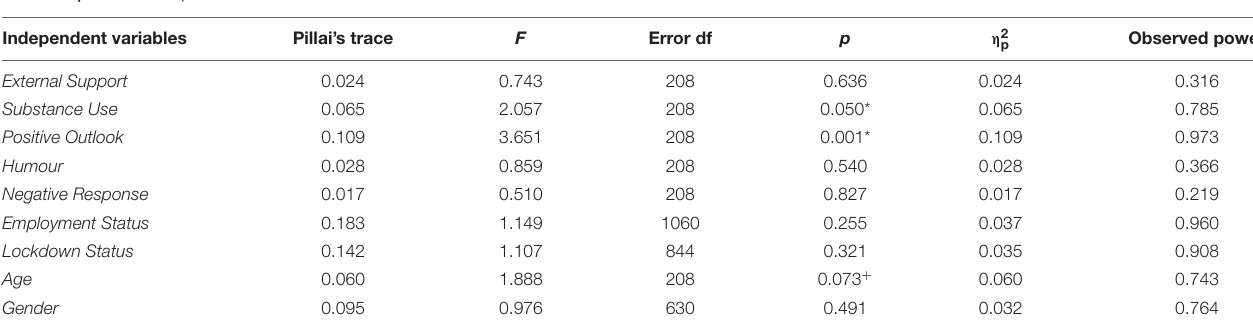
TABLE 6 | MANOVA of predictors of MMR factor scores.